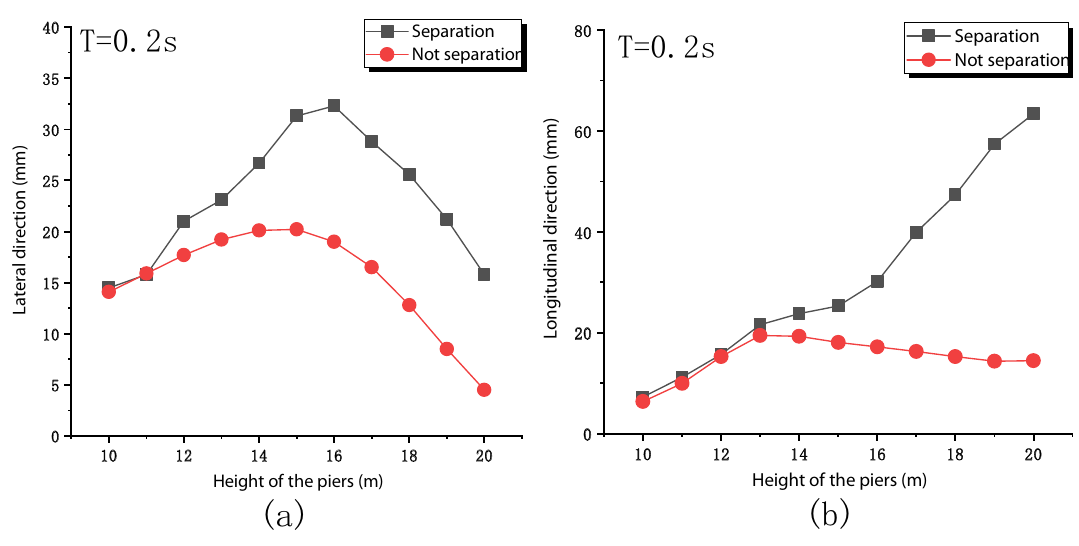
Figure 9. Horizontal deformation of pier top under different pier heights: ( a ) Lateral direction; ( b ) Longitudinal